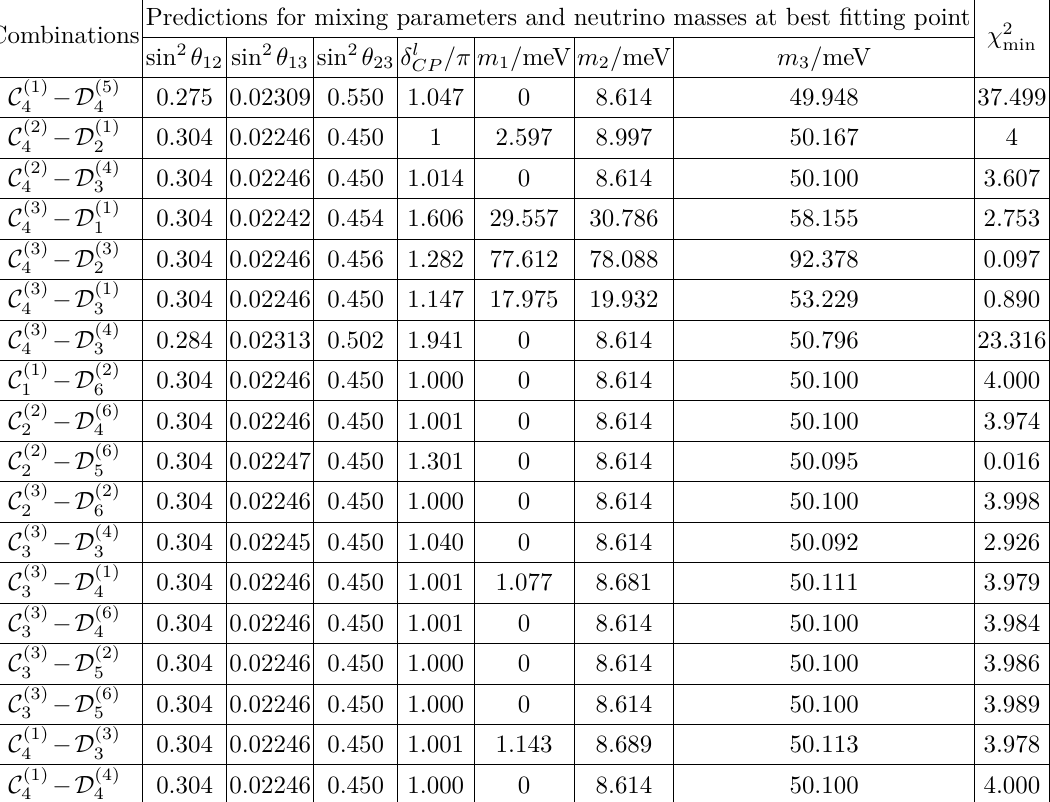
Table 15. Best-fit values of the lepton mixing and neutrino mass parameters for the representative models of table 14. In all representative models, the predictions of the lepton mass ratios are m e /m µ = 0 . 00474 , m µ /m τ = 0 . 0586 and ∆ m 2